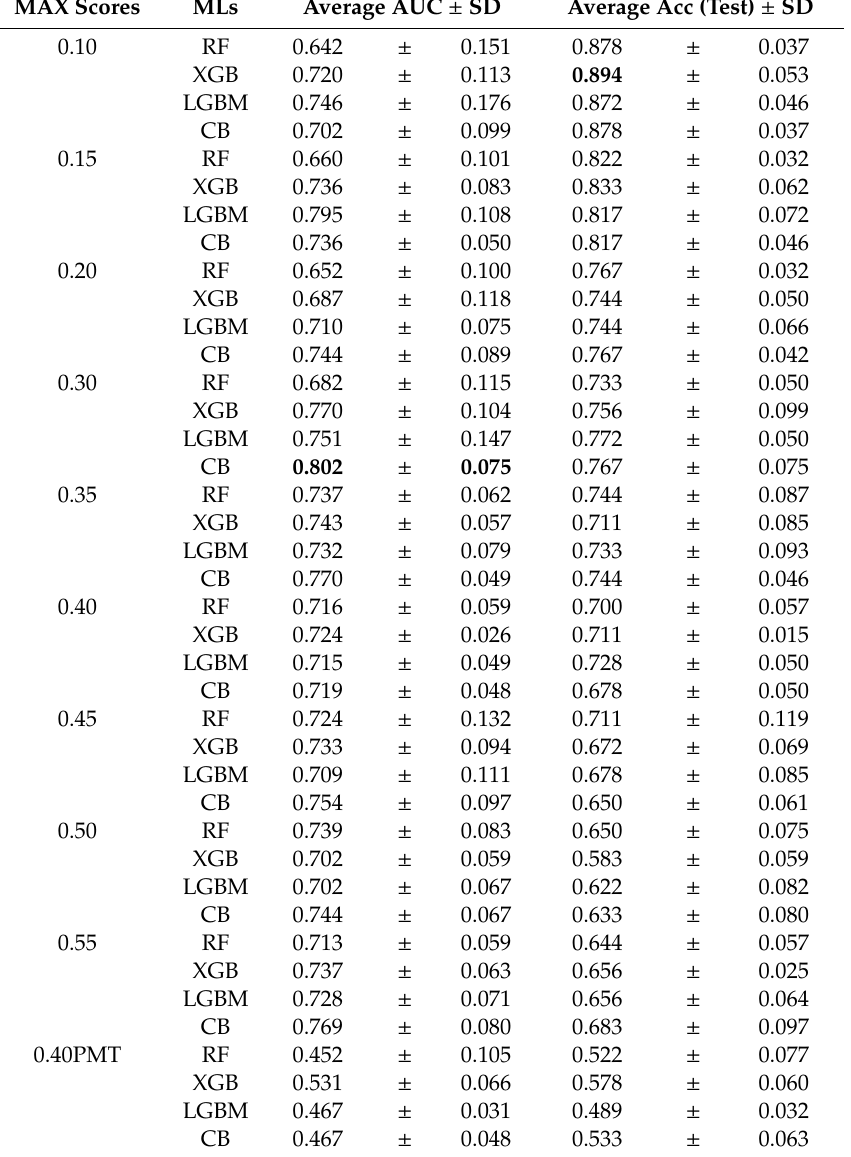
Table 2. Performance of prediction models with thresholds of MAX score by